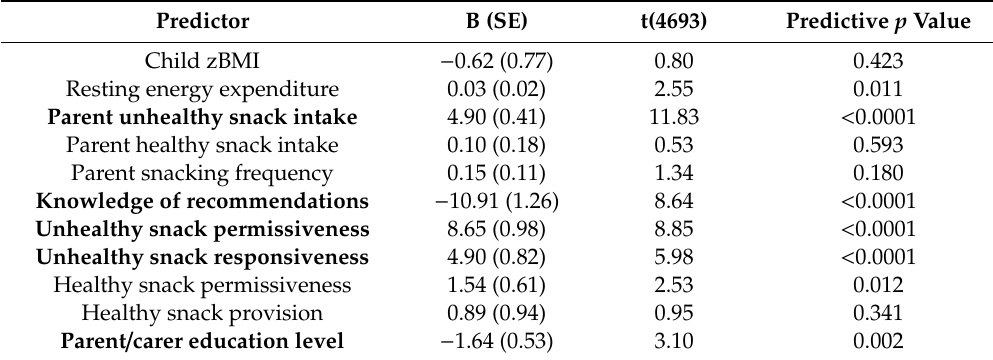
Table 7. Hierarchical linear regression statistics for predictors of child unhealthy snack